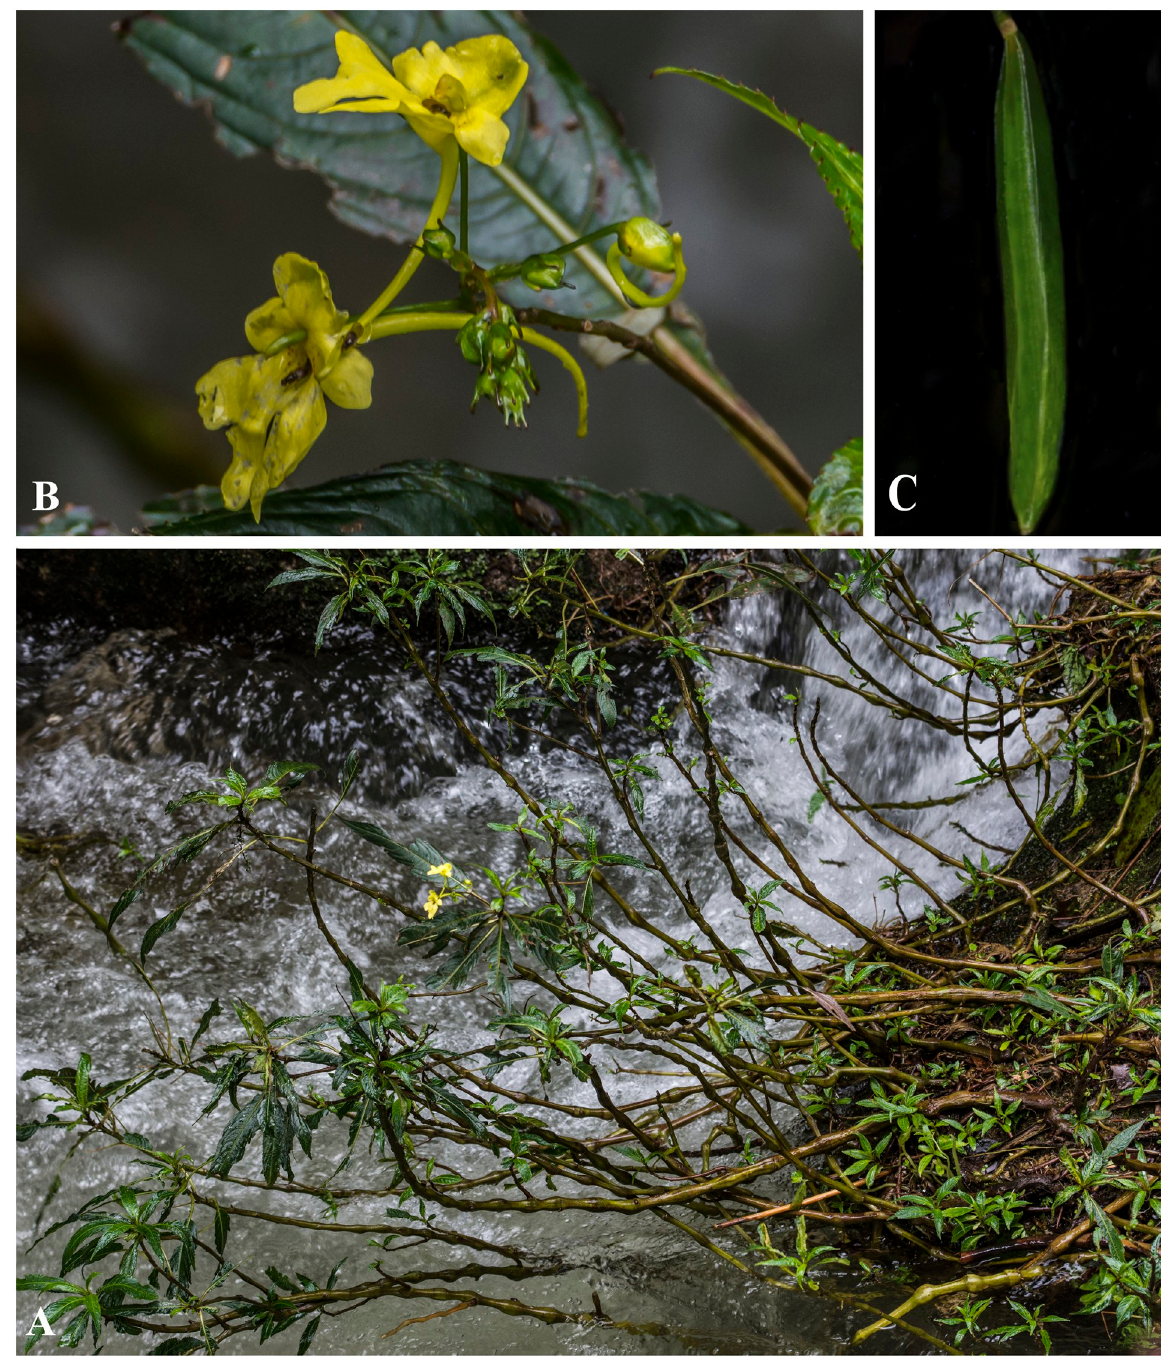
Fig 19. Impatiens leptoceras A. Flowering plant; B. Flower; C. Capsule. Photographs by Bhakta Bahadur Raskoti.